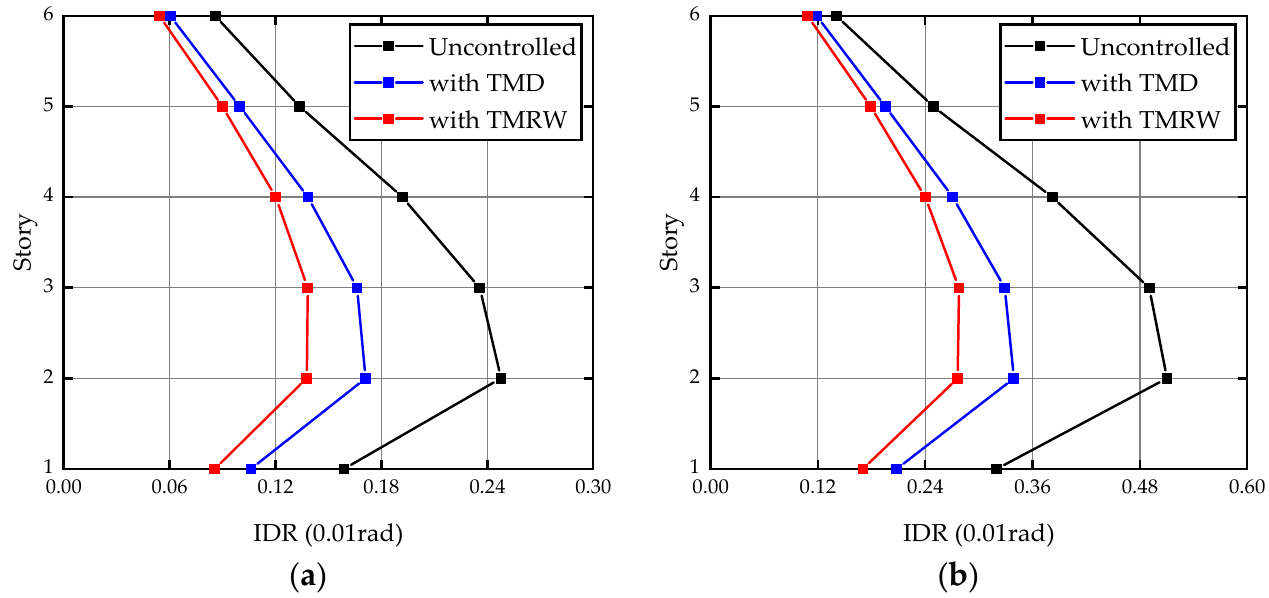
Figure 14. Comparison of the IDRs under Taft earthquake excitation: ( a ) 0.1 g case; ( b ) 0.2 g case. Table 3. Comparison of control effectiveness under Taft earthquake excitation. Excitation Responses